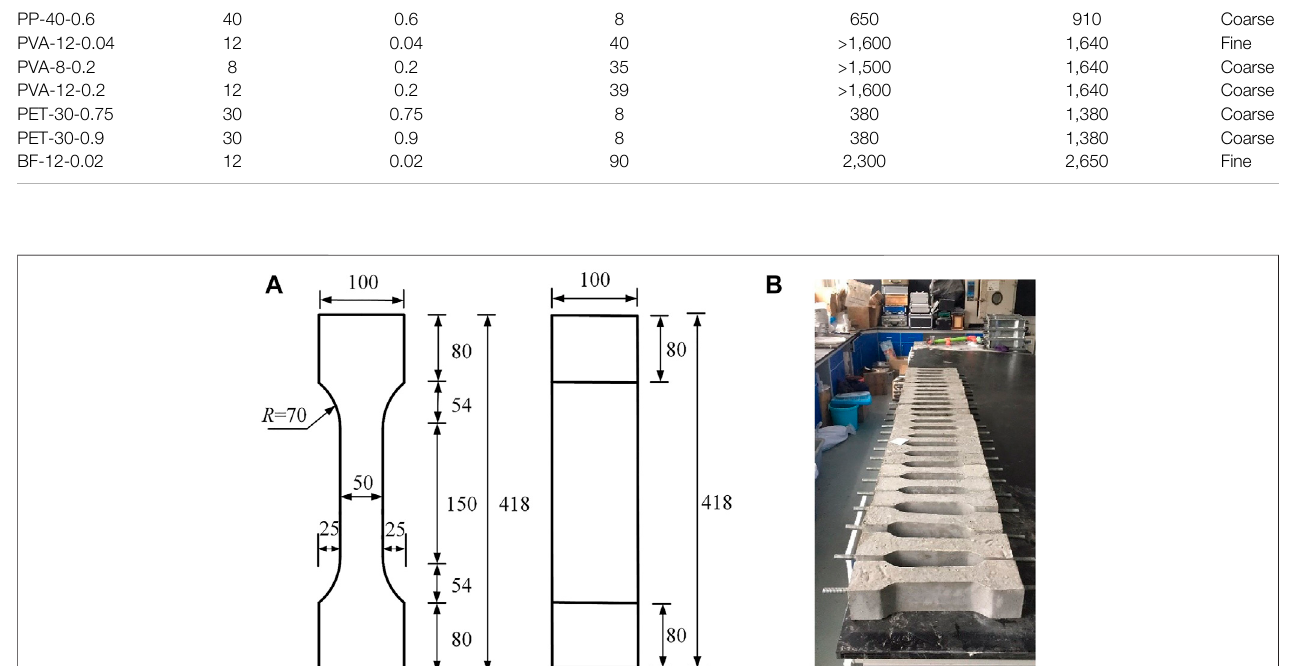
TABLE 4 | Specimen